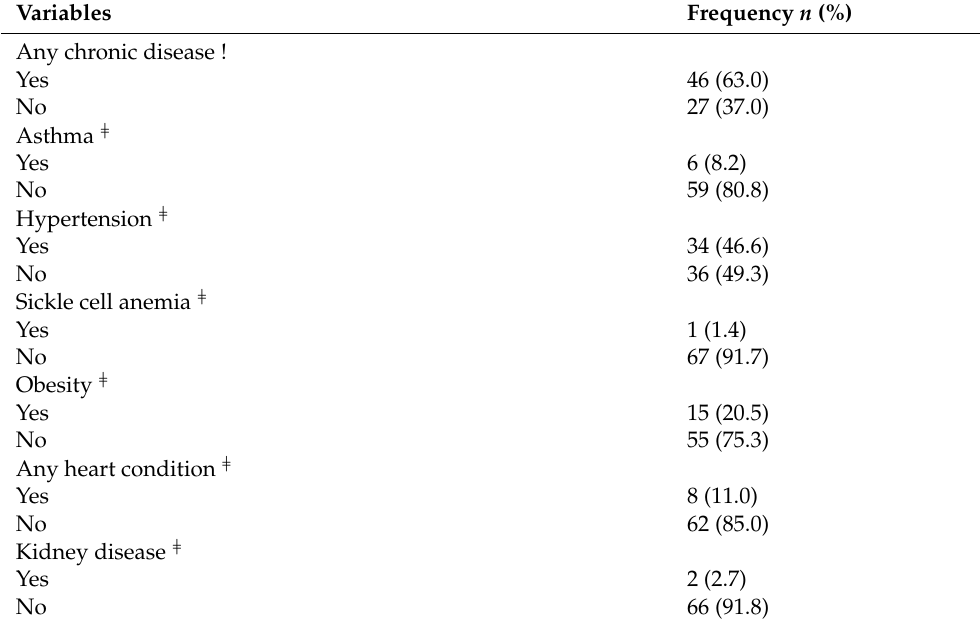
Table 2. Other self-reported health conditions of study participants ( n = 73).